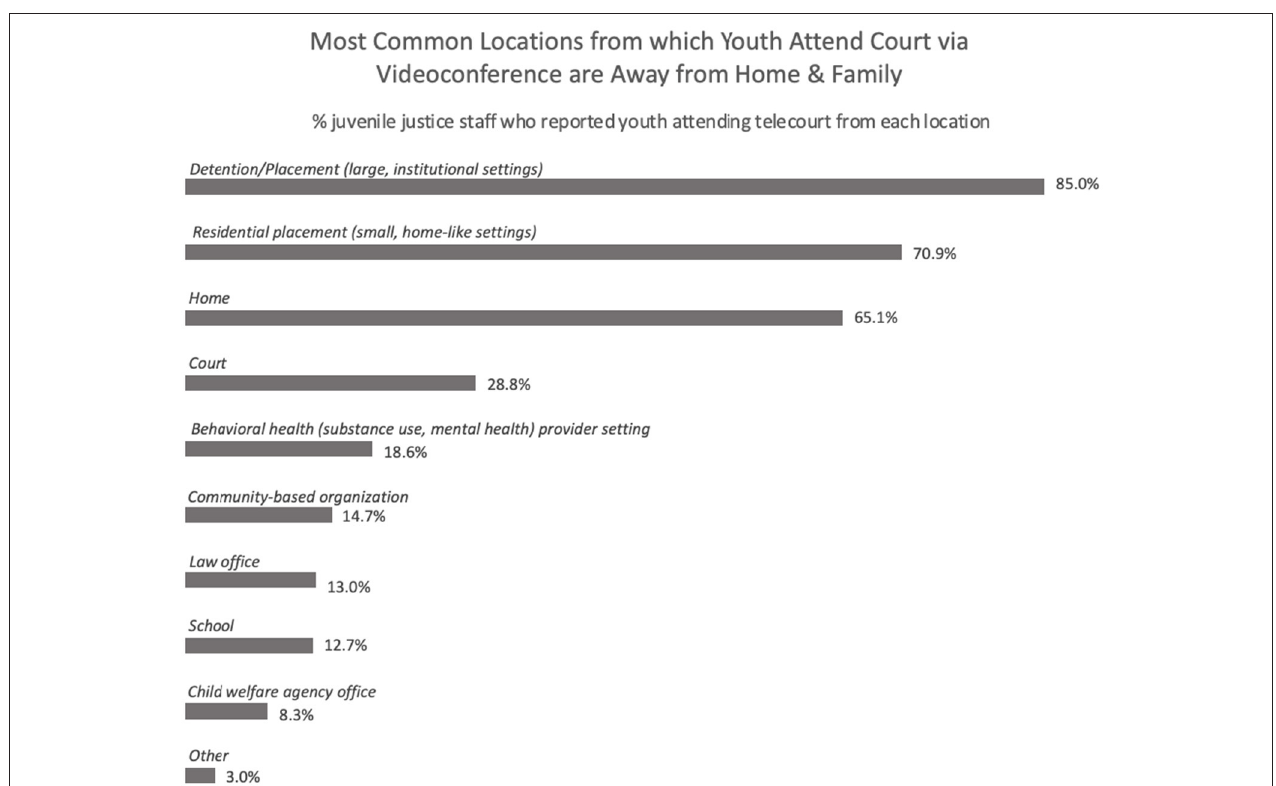
FIGURE 2 | Locations from which youth attend court hearings using video